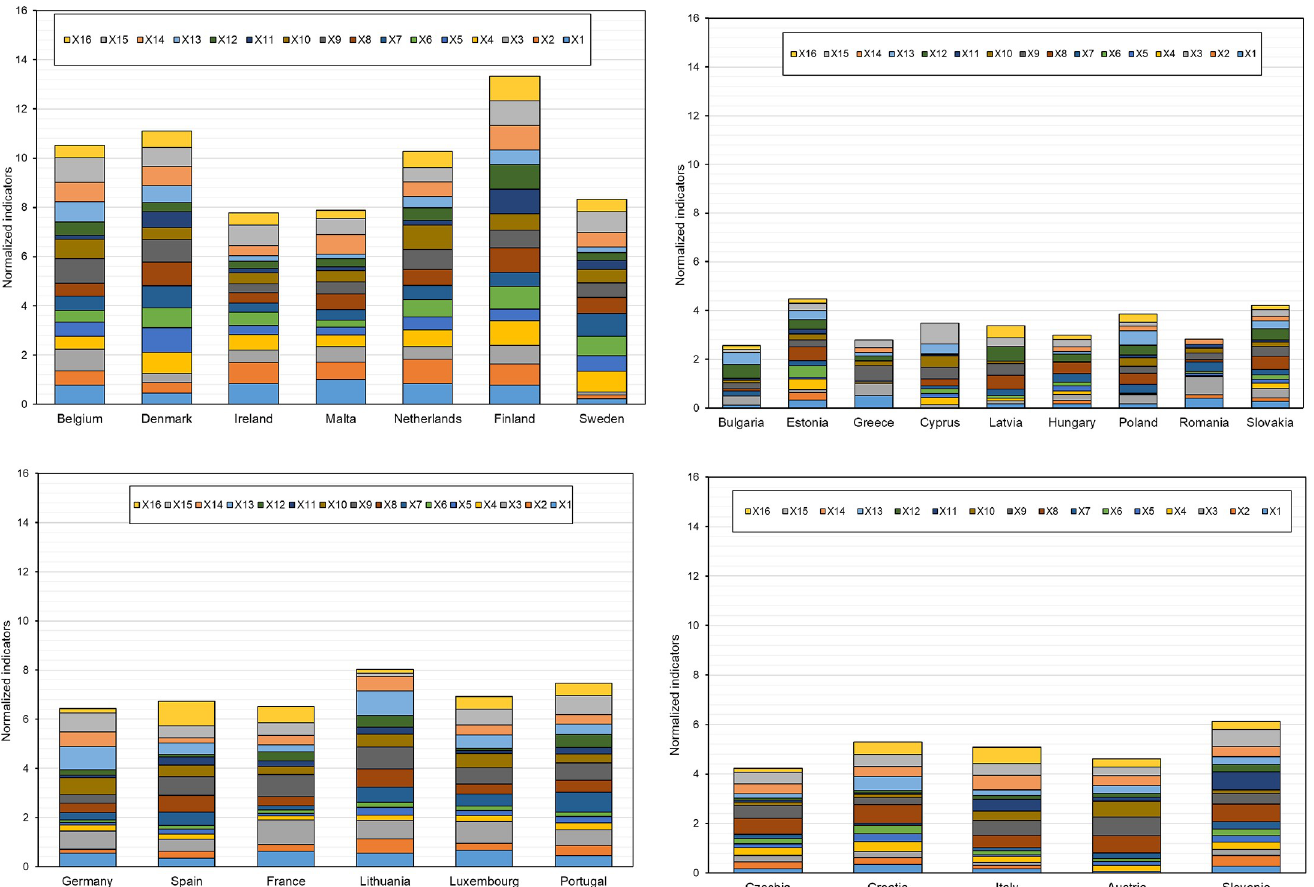
Fig 8. The summary of studied indicators on digitalization and robotization of small enterprises for the EU countries in the designated similar groups (a-cluster 1, b- cluster 2, c-cluster 3, d-cluster 4).